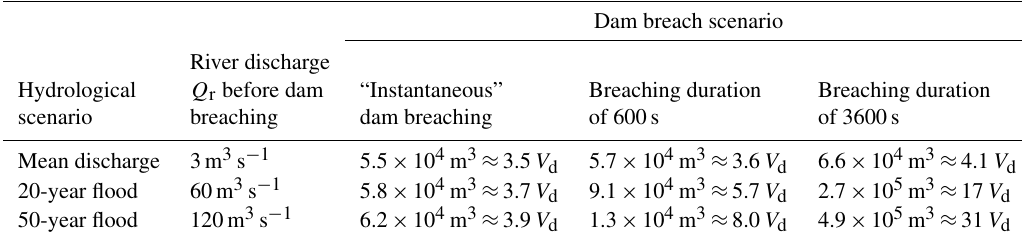
Table 11. Estimated volume of water released at the dam over the breaching duration, evaluated as V l + T c × Q r . Notation V l refers to the volume of water initially impounded behind the landslide dam, Q r , to the river discharge before dam breaching, and T c is a characteristic time, taken equal to 60s for the extreme scenario of instantaneous dam breaching and equal to T f (breaching duration) in the other cases. Notation V d designates the volume of the